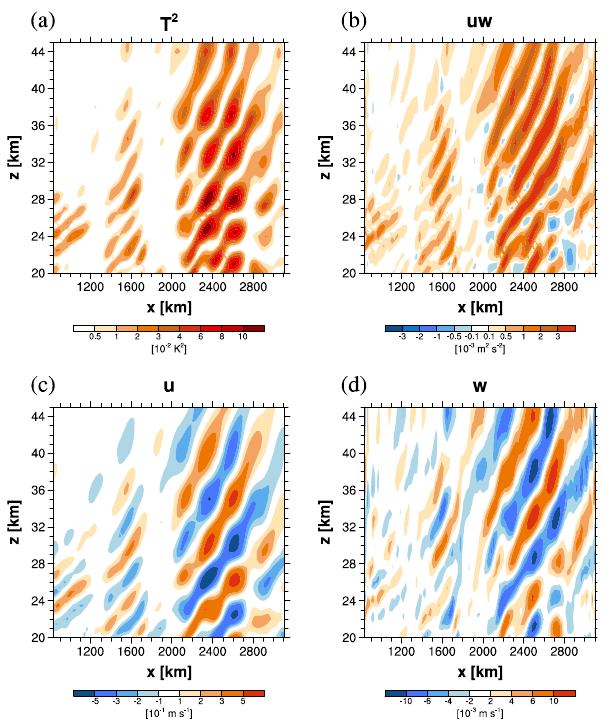
Fig. 2. x – z cross sections of (a) temperature variances, (b) covari- ances between the zonal and vertical wind perturbations, (c) zonal Figure 2. x – z cross sections of (a) temperature variances, (b) covariances between the zonal and wind perturbation, and (d) vertical wind perturbation for purely vertical wind perturbations, (c) zonal wind perturbation, and (d) vertical wind perturbation for eastward propagating waves (waves propagating along the x-axis) purely eastward propagating waves (waves propagating along the x -axis) at 0000 UTC 8 July. The at 00:00UTC, 8 July. The variables are normalized by the basic variables are normalized by the basic density in (a) and (b) and by the square root of the basic density in (a) and (b) and by the square root of the basic density in density in (c) and (d). (c) and (d) .